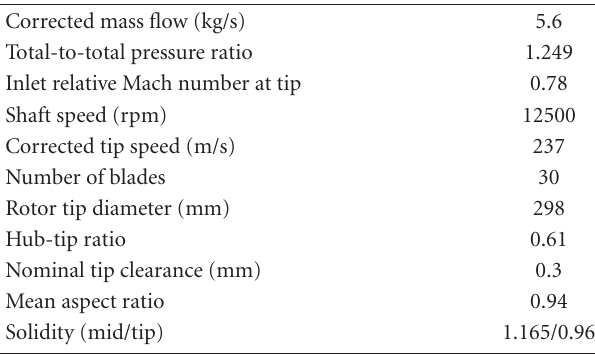
Table 1: Design specifications of compressor